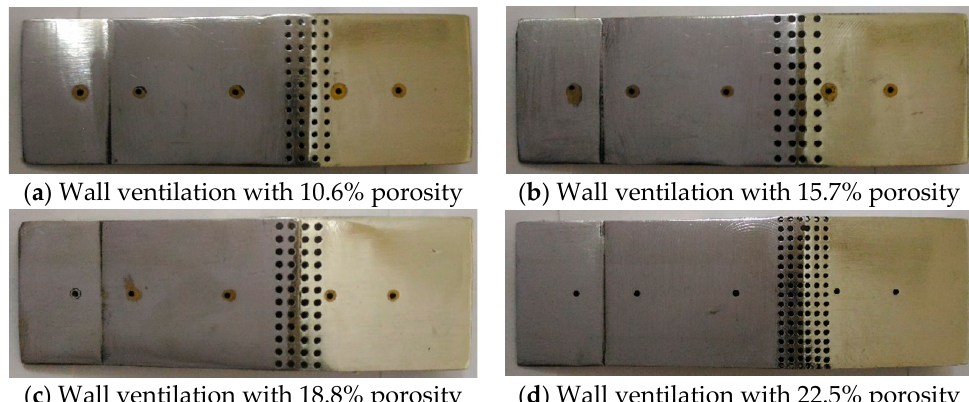
Figure 5. Photographic views of the intake-cores controlled by wall ventilation. Figure 5.